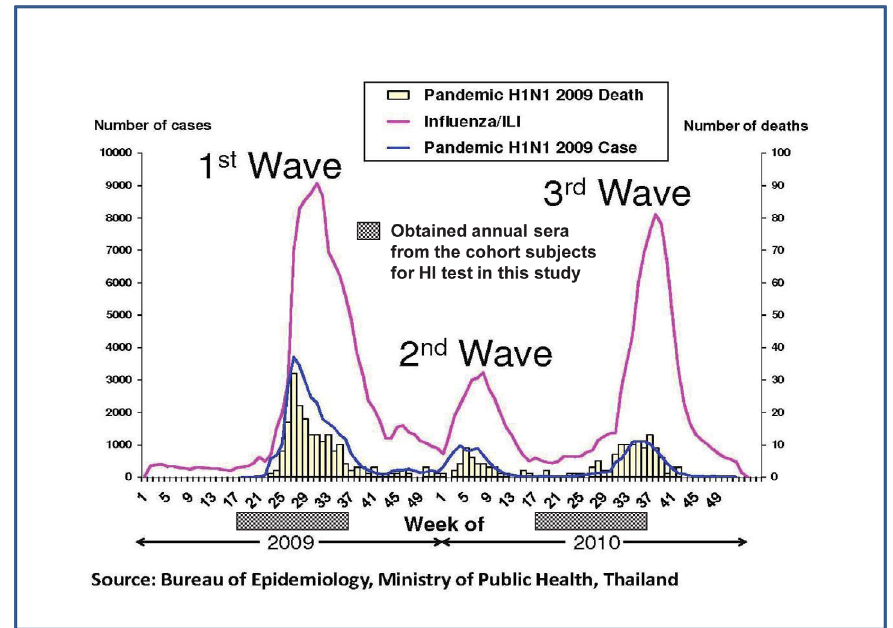
Figure 1. Three waves of the pandemic influenza A(H1N11)pdm09 in Thailand. Source: Bureau of Epidemiology, Ministry of Public Health, Thailand.